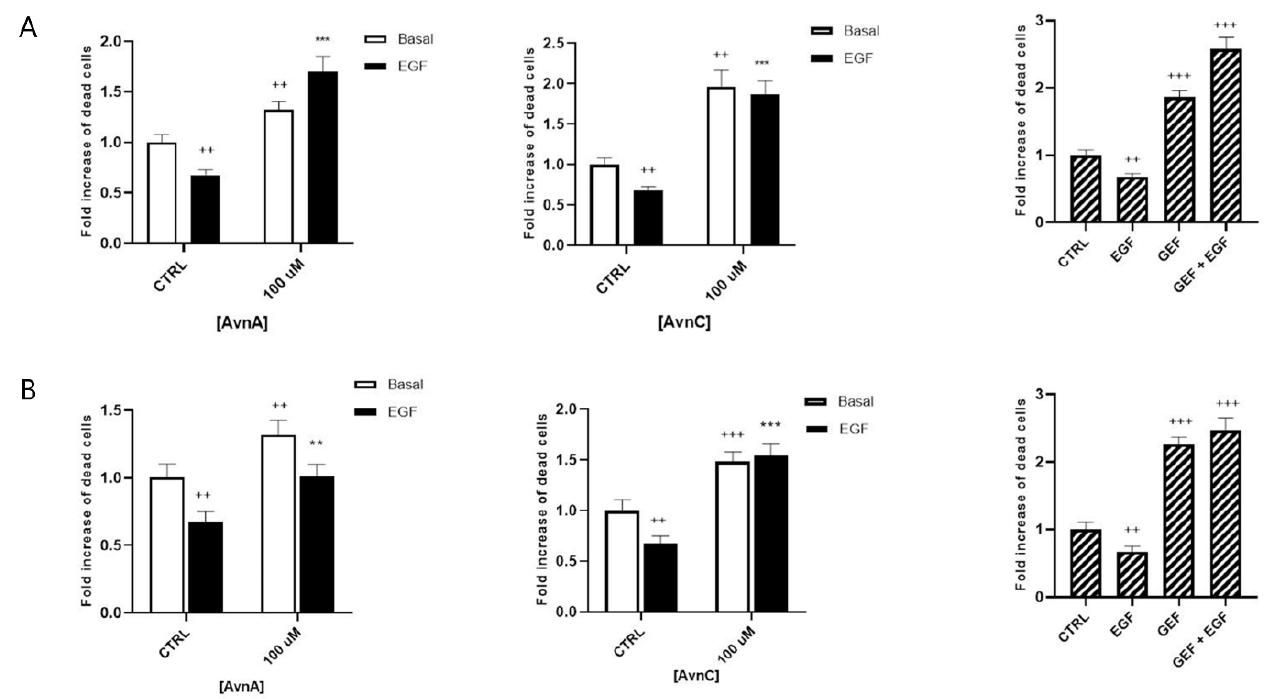
Figure 3. Effect of Avns on anoikis after 24 ( A ) and 48 ( B ) h. Cell vitality of A549 in suspension treated with Avns (100 μ M) in 0.1% of serum. Results are expressed as fold of increase of dead cells and are representative of three independent experiments run in triplicate. Statistical analysis: +++ p < 0.001 and ++ p < 0.01 vs. CTRL; *** p < 0.001 and ** p < 0.05 vs. EGF.